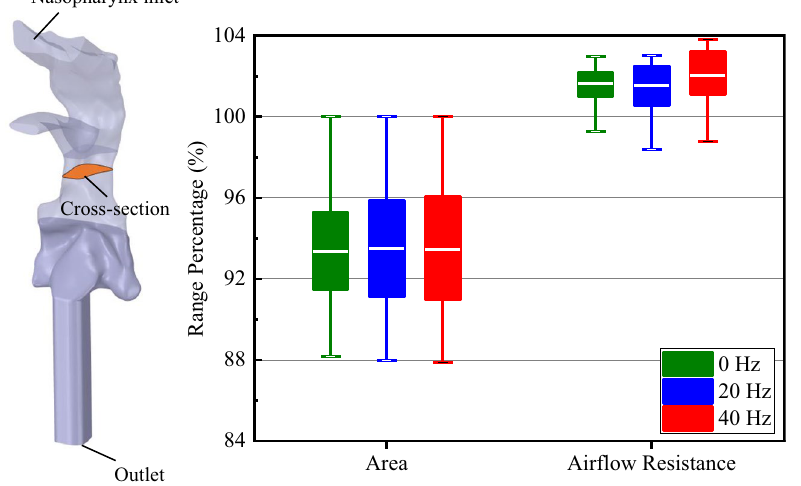
Figure 3. Comparisons of the time-varying cross-sectional area and the pharyngeal airflow resistance at three flapping frequencies. The cross-sectional areas are normalized using the initial value (113.74 mm 2 ) to obtain their percentage change during the simulation. The pharyngeal airflow resistance is defined by R = � P / Q , where (cid:31) P is the difference of area-averaged pressure between the nasopharynx inlet and the pharyngeal airway outlet, and Q is the instantaneous airflow rate. The R in this figure is normalized using the initial value of 3.3353 Pa L/min (the airflow resistance of the stationary airway). Data are obtained at each time step during the simulations, and the boxes represent 90% of the data distribution